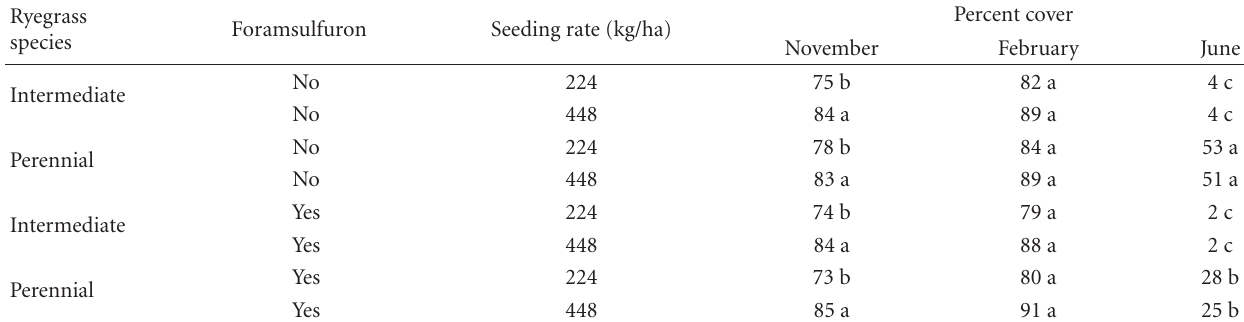
Table 1: Percent cover of ryegrasses as a ff ected by seeding rate, foramsulfuron application, and overseeded species in 2004 for the first experiment. a